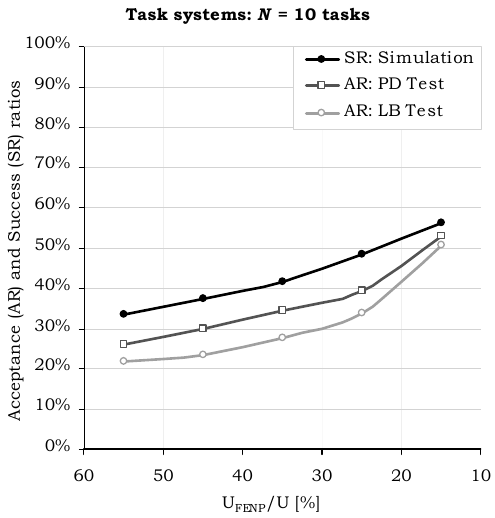
Figure 8. Sufficiency tests and simulation results, while decreasing the utilization factor of the FENP tasks ( U FENP / U ratio).